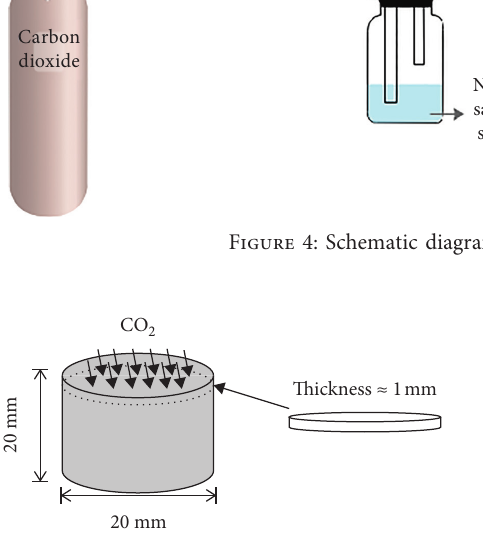
Figure 5: Schematic diagram of sample